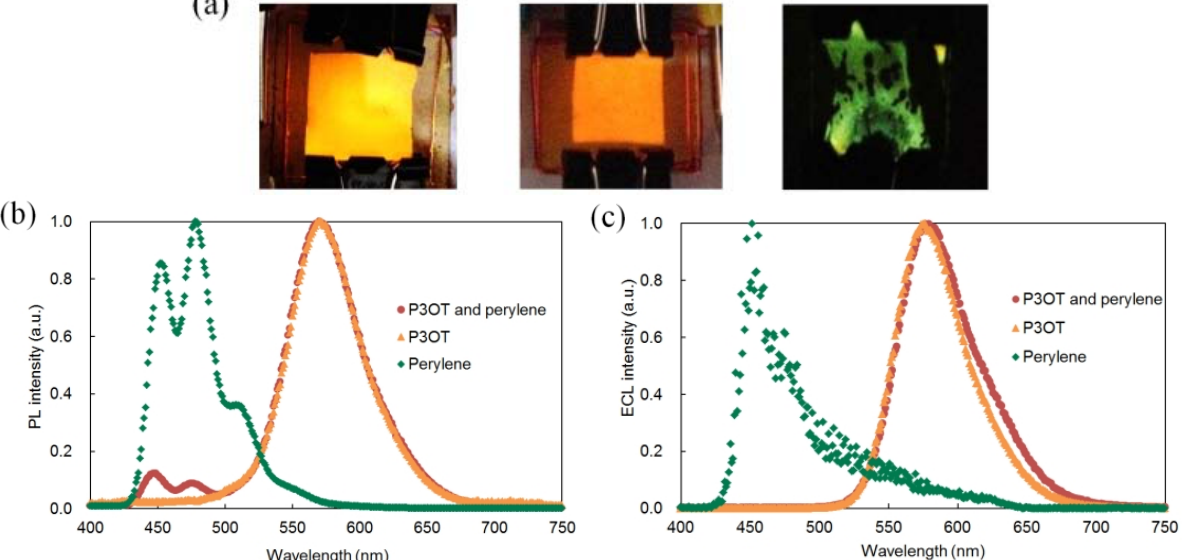
Figure 2. ( a ) Photographs of ECL from the ECL device using: (top) Poly(3-octylthiophene-2,5-diyl) (P3OT) and perylene under application of AC voltage of 5.0 V at 250 Hz; (center) P3OT under the application of AC voltage of 5.0 V at 250 Hz; (bottom) perylene under the application of AC voltage of 12.0 V at 50 Hz. ( b ) Photoluminescence (PL) and ( c ) ECL spectra of each device. Applied voltages are the same as those of ( a ). PL spectra are observed upon excitation with a 350 nm xenon